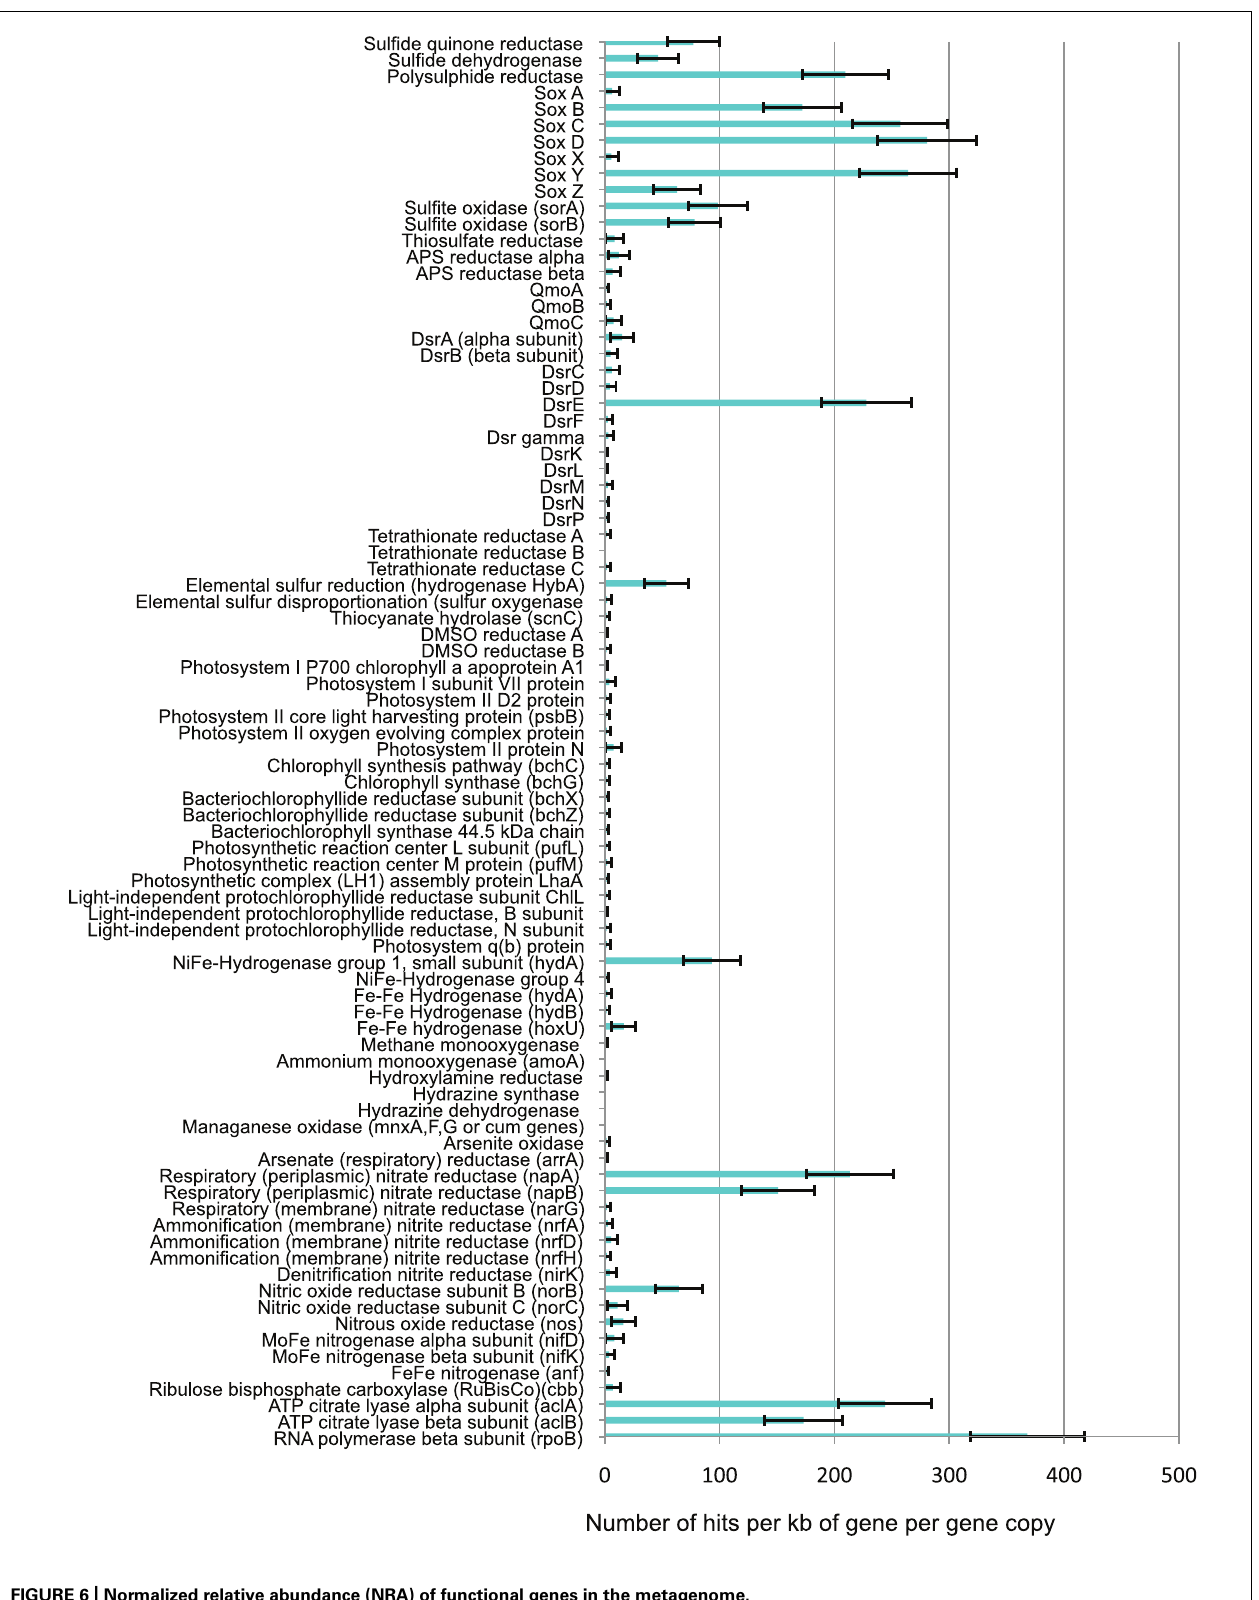
FIGURE 6 | Normalized relative abundance (NRA) of functional genes in the metagenome.